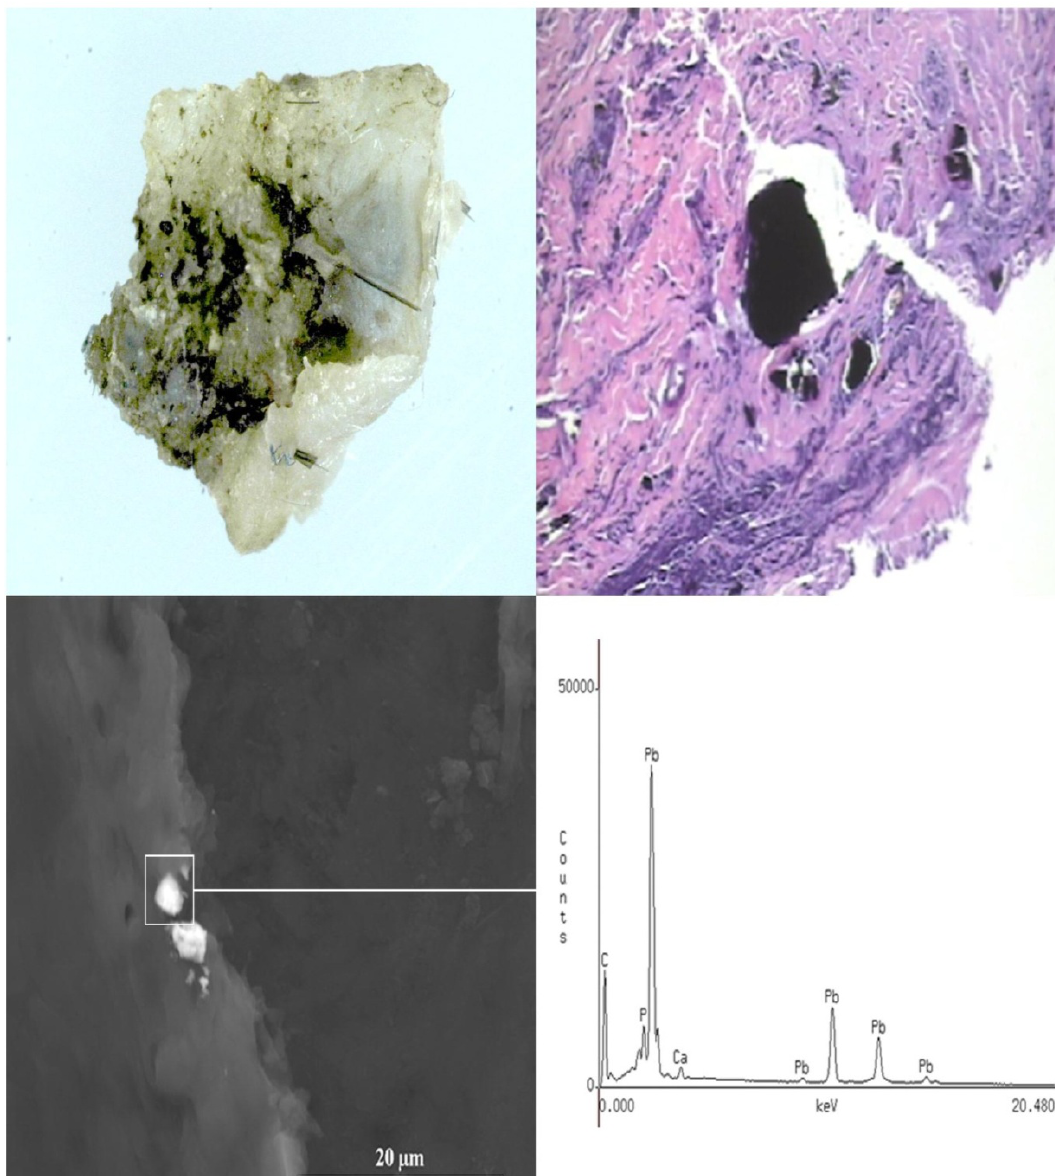
Figure 8. Case 4: Gross photograph ( A ) of a retained fragment (black area) surrounded by fibroadipose tissue (white area); ( B ) Hematoxylin & eosin (H&E) stained section demonstrating granular black fragments. Scanning electron microscopy image and EDXA spectrum ( C ) of a tissue section demonstrating the presence of a metallic lead fragment within the fibroadipose